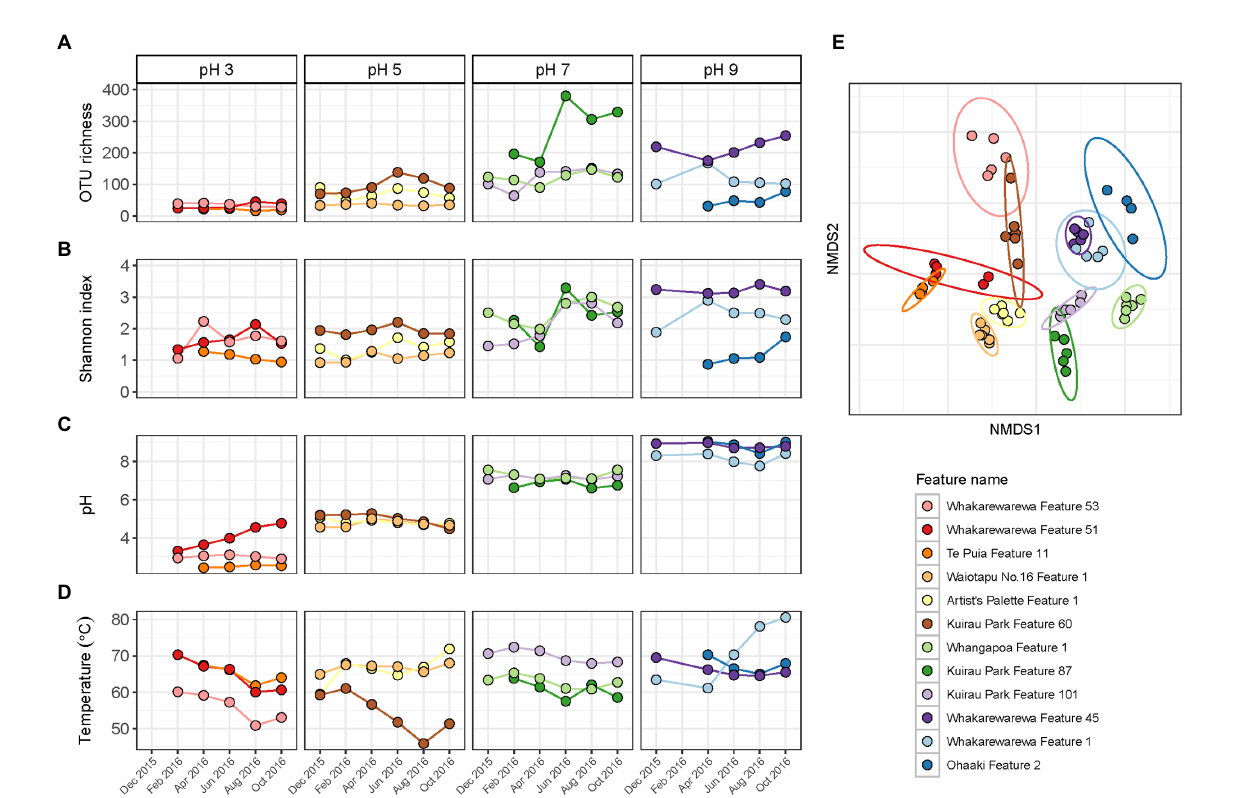
FIGURE 6 Temporal diversity and physicochemistry of geothermal features from across the pH range. (A) The microbial communities of 12 geothermal springs were measured six times over 1 year by amplicon sequencing of the 16S rRNA gene, with variation in alpha diversity between temporal samples indicated by OTU richness (i.e., the number of OTUs per community). (B) Alpha diversity was also measured by the Shannon diversity index to indicate evenness of the communities over time. (C) Spring pH of the features at the time of sampling. (D) Spring temperature of the geothermal features. (E) Beta diversity of the 12 features is shown by a non-metric multidimensional scaling (NMDS; n = 62, stress = 0.15) of Bray-Curtis dissimilarities between all temporal samples, with data ellipses generated from multivariate t-distribution with a 95% confidence level. All samples are coloured according to feature name, with alpha diversity and physicochemistry further grouped by pH